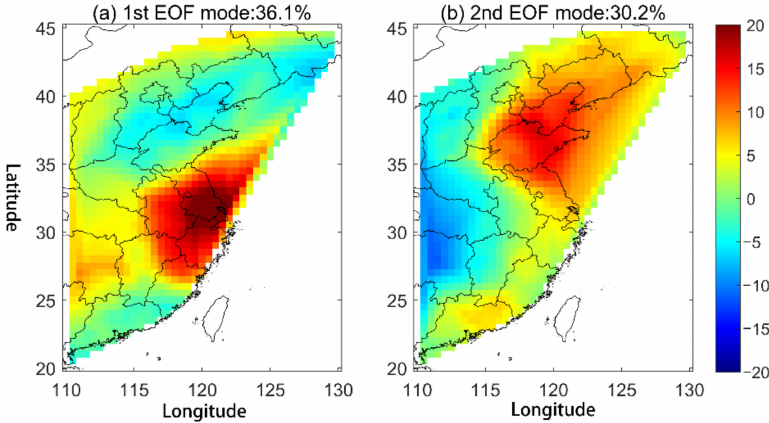
Figure 5. Two leading EOFs of the PWV anomalies.